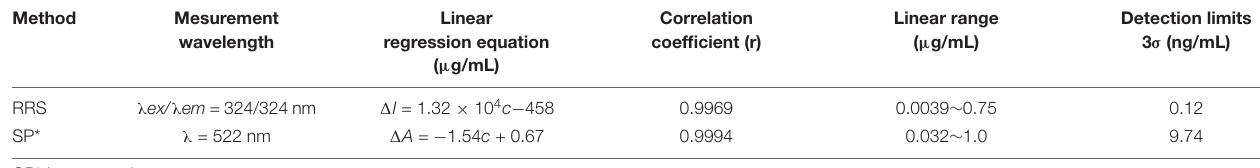
TABLE 1 | Related parameters of the calibration graphs and the detection limits.